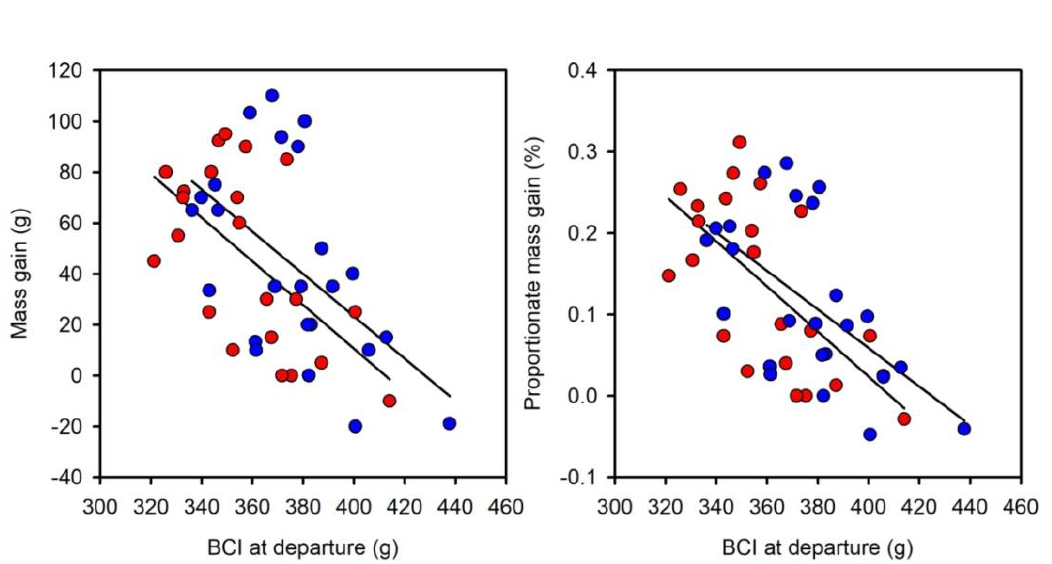
Figure 7. Mass gain and proportionate mass gain as a function of body condition before a foraging trip for male (blue) and female (red) snow petrels sampled at Ile des Pétrels, Adélie Land, East Antarctica. Male mass gain: F 1,23 =10.010, P=0.004, r²=0.303; female mass gain: F 1,20 =11.071, P=0.003, r²=0.356; male proportionate mass gain: F 1,23 =12.361, P=0.002, r²=0.350; female proportionate mass gain: F 1,20 =13.258, P=0.002,